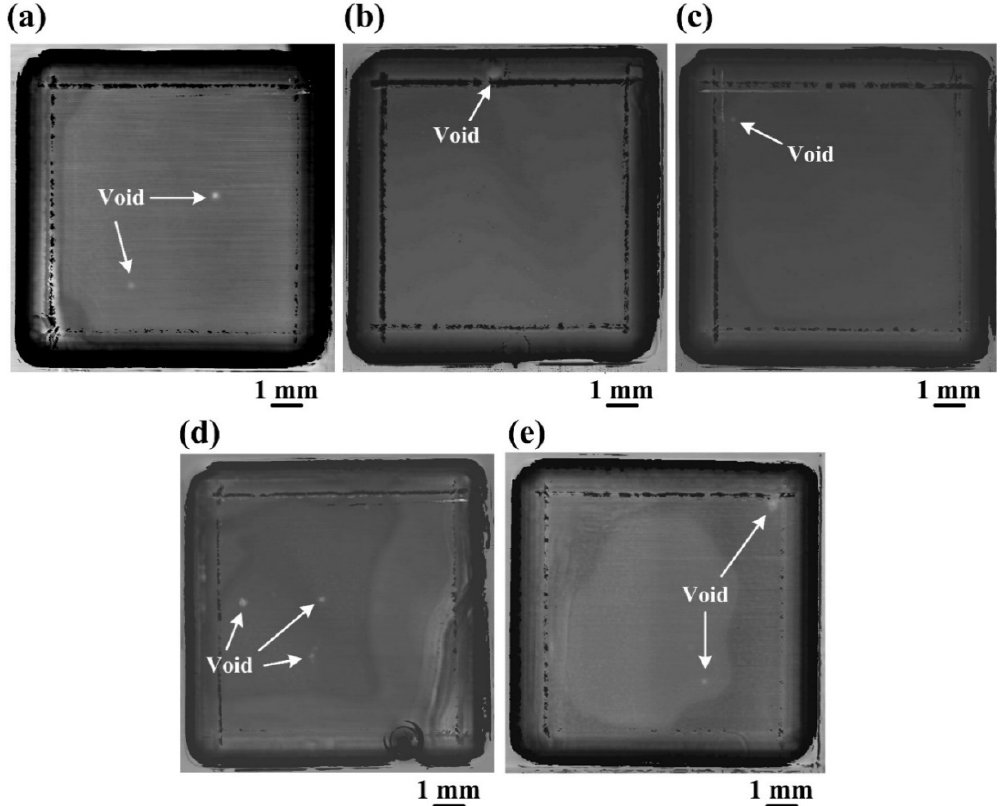
Figure 1. SAM images of the bonded Si-Si specimens activated under the Ar ion beam currents of ( a ) 10 mA, ( b ) 20 mA, ( c ) 30 mA, ( d ) 40 mA and ( e ) 50 mA, respectively.